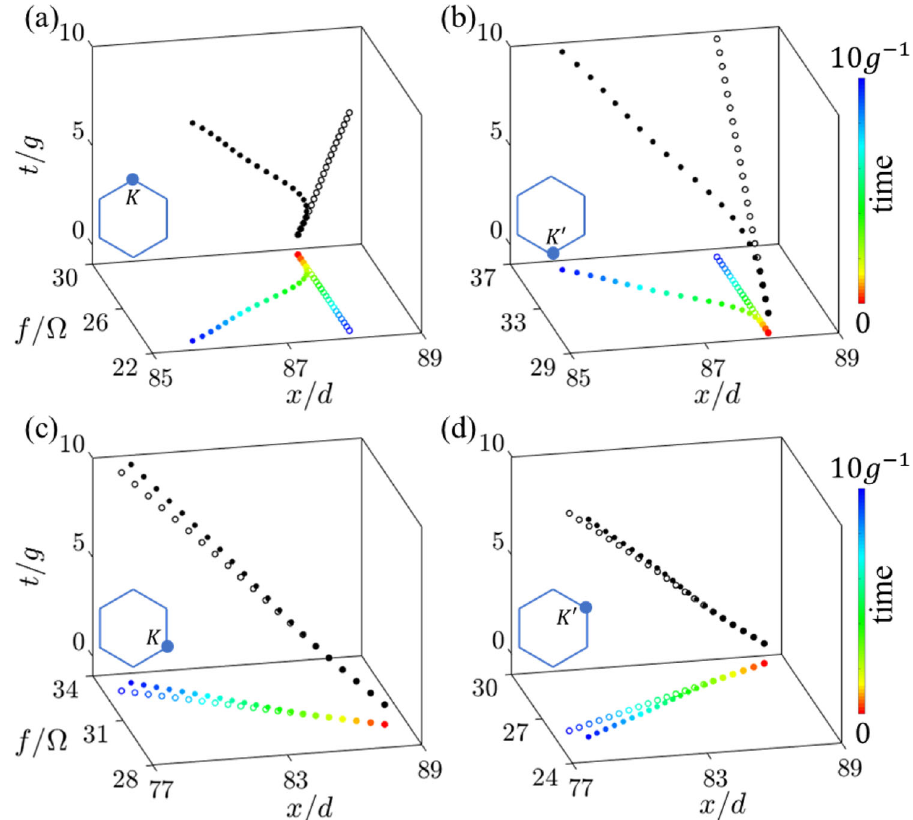
Fig. 5 Valley-dependent Lorentz force. The simulated trajectories of the center of the Gaussian-shape wave packet ( x c , f c ) at discrete times with time interval δ t = 0.5 g − 1 , where g is the effective hopping amplitude. The lattice is excited by initial source in the vicinity of the Dirac point K or K 0 with a ( k x , k f ) = (0, 4.4 π /3 Ω ), b ( k x , k f ) = (0, − 4.4 π /3 Ω ), c ( k x , k f ) = (2.2 reciprocal to spatial and frequency axes, Ω is the free spectral range, d denotes the horizontal distance between two sites with the same types in the synthetic lattice, and t is propagation time. The trajectory with a black solid (hollow) circle represents the motion of the wave packet in the case with (without) the valley-dependent Lorentz force, which is projected into the spatial-frequency ( x , f ) plane with the varying color of circles representing the center position in the synthetic lattice at different simulation